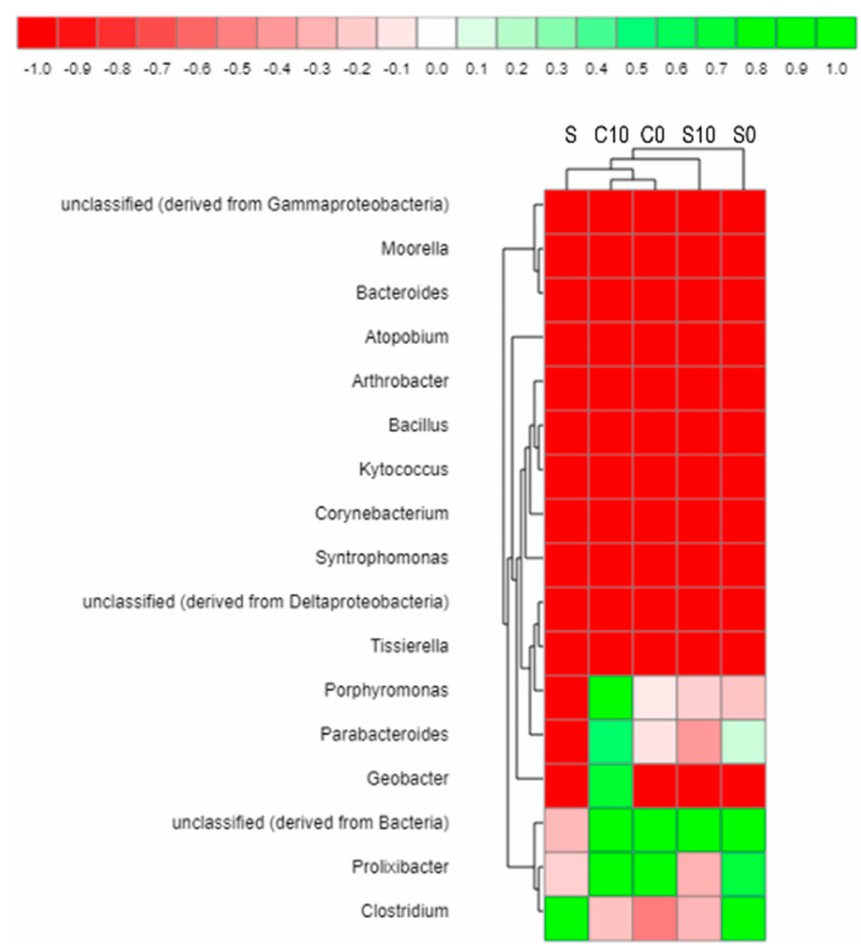
Figure 4. Heatmap of bacteria at genus level. Genus level with relative abundance lower than 1% were included in unclassified groups. Sludge from control reactor (S), sludge from reactor with granular activated carbon (GAC) (S0), sludge from reactor with GAC biofilm developed before undertaking the BMP test (S10), GAC biofilm from reactor with GAC (C0), and GAC biofilm from reactor with GAC biofilm developed before undertaking the BMP test (C10). Heatmap showing the 17 genera with significant difference of relative abundances among five samples. Heatmap is color-coded based scale (from red ( − 1) less abundance to green (+1) more